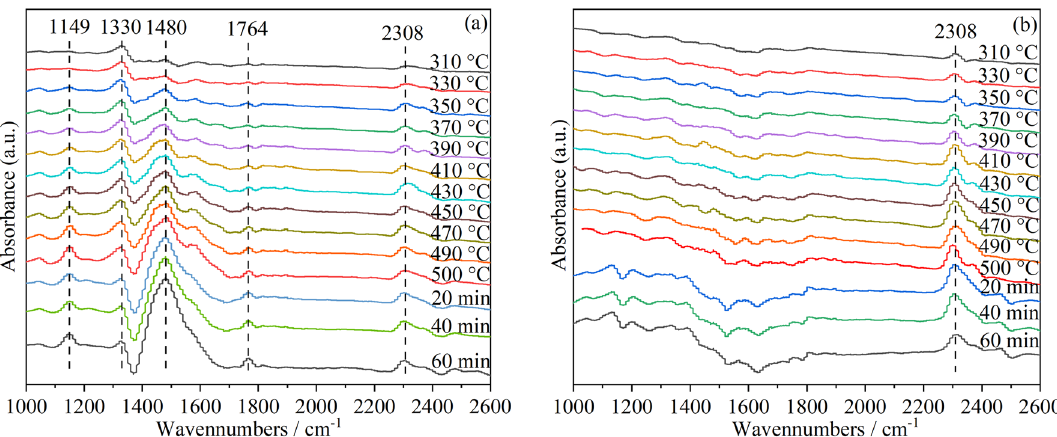
Figure 10. In situ IR spectra for soot catalytic combustion in the flows of 5 vol% O 2 + He on ( a ) CM-NaC; ( b )